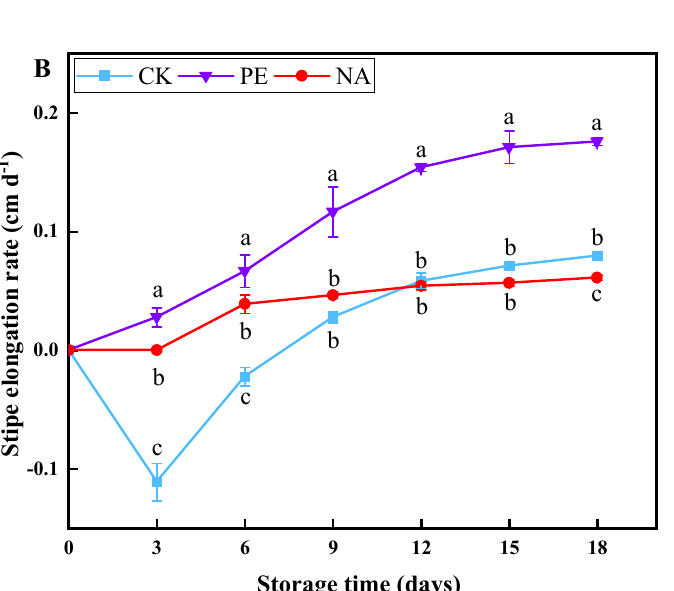
Figure 2. Effects of different types of packaging on sensory quality ( A ) and the postharvest elongation of F. velutipes stipes ( B ).